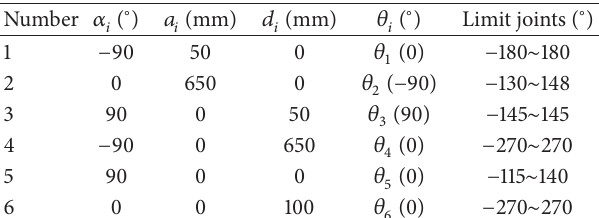
Table 1: D-H parameters of the TX90XL